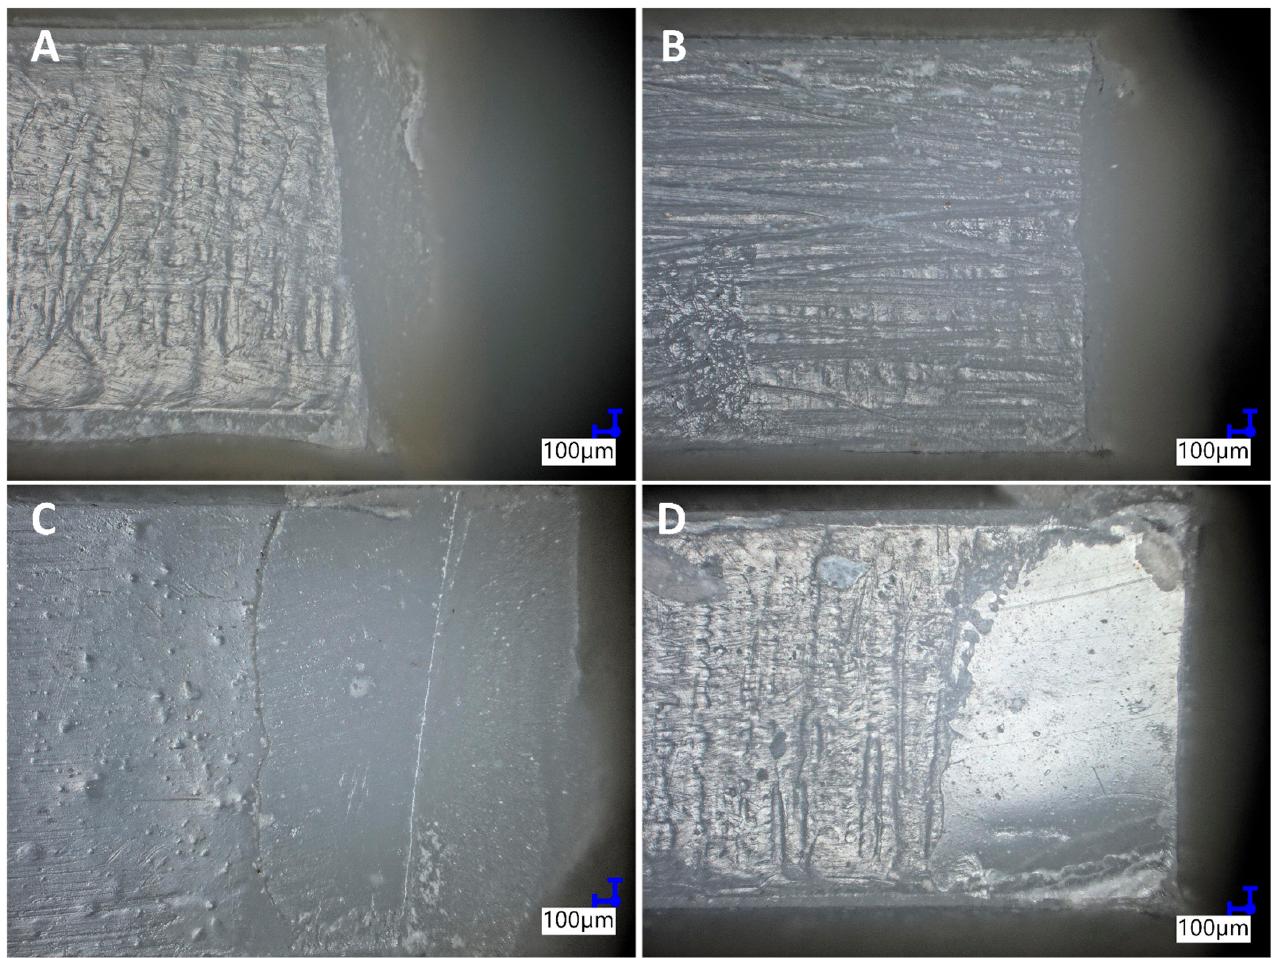
Figure 9. Digital optical micrographs of the studied systems: ( A )—2% MATMOS; ( B )—2% 6MA; ( C )—2% 4MA; ( D )—2% 2MA. For ( A , B ), joint adhesion failure was observed. For ( C , D ), mostly composite failure was observed.